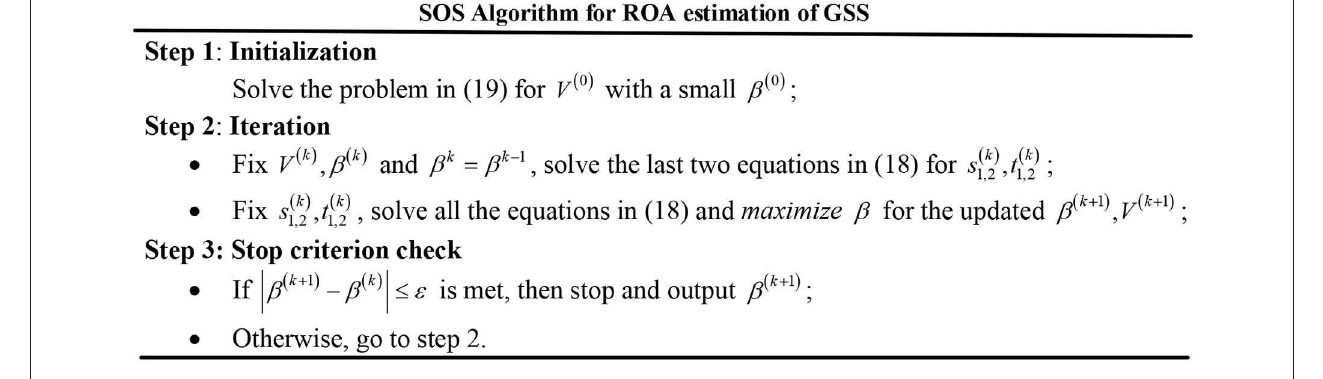
FIGURE 4 | SOS algorithm for ROA estimation of GSS.